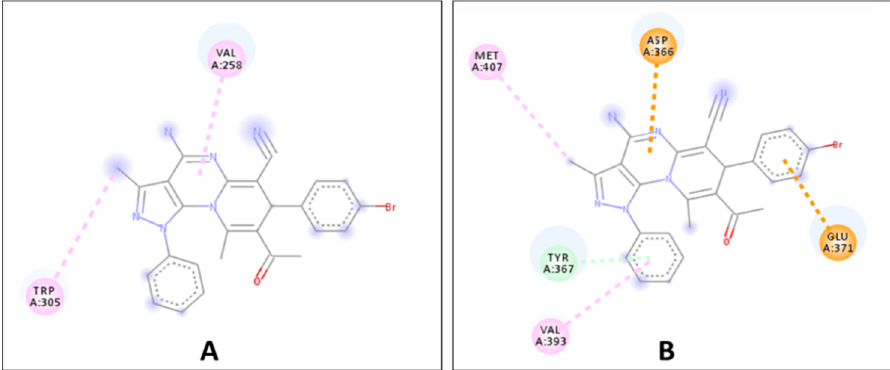
Figure 5. Docking pose (2D binding model) of the most active cytotoxic agent, 7e , in the active site of MCL-1 (PDB: 3MK8) ( A ) and USP7 (PDB: 4M5W) ( B ).